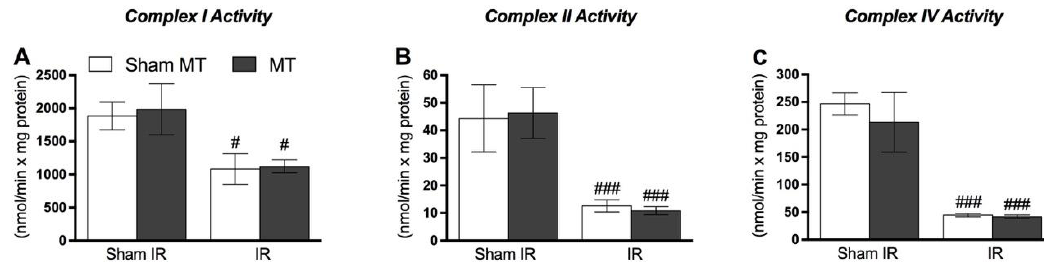
Figure 5. E ff ects of MT on mitochondrial function at the 2nd day after IR procedure. Complex I activity ( A ), Complex II activity ( B ) and complex IV activity ( C ) all panels show that IR reduces mitochondrial function but ankle joint mobilization could not prevent the mitochondrial function reduction. Each point represents the mean of 8 animals and vertical lines show the SD. Statistical analyses were performed by One-way ANOVA followed by Newman–Keuls multiple comparison test. The symbols denote a significant di ff erence of # p < 0.05 or ### p < 0.001 when compared to Sham + Sham MT group. MT: Manual therapy, IR: Ischemia and reperfusion.